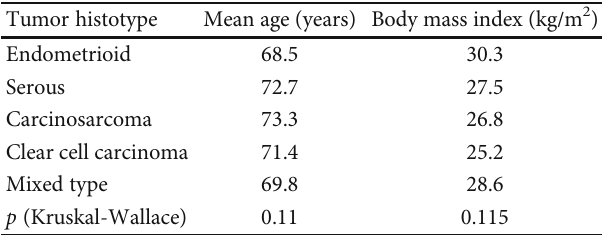
Figure 2: Self-organized hierarchical clustering of 12 biomarkers in 274 endometrial cancers. Dendrogram shows degree of marker association (distance measure) in 274 cases with complete data for all markers (cases with partial missing data excluded for computational reasons). Estrogen (ER) and progesterone (PR) receptor results scored dichotomously across a 10% threshold. Two major clusters are evident, containing P53 and PTEN, respectively. Ward ’ s linkage method and Jaccard similarity coe ffi cient distance metric for binary data. Distal branches, such as those containing ER + PR and p16 + p53 , indicate a level of association between members of the limb. Table 3: Mean age and body mass index at presentation by tumor